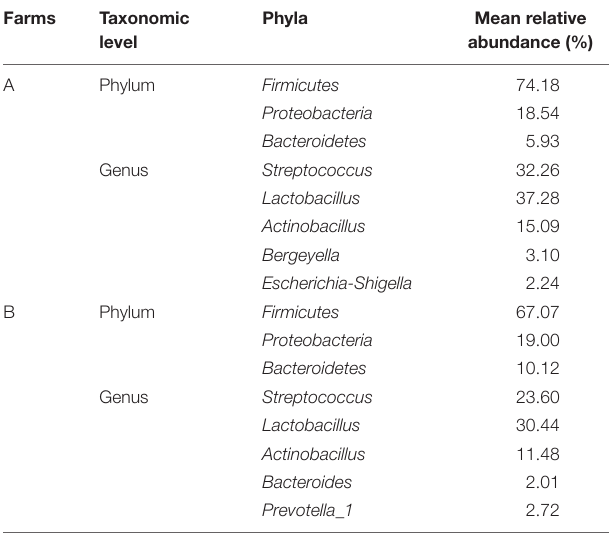
TABLE 2 | The core microbiota in the oropharynx of healthy piglets from the two farms.